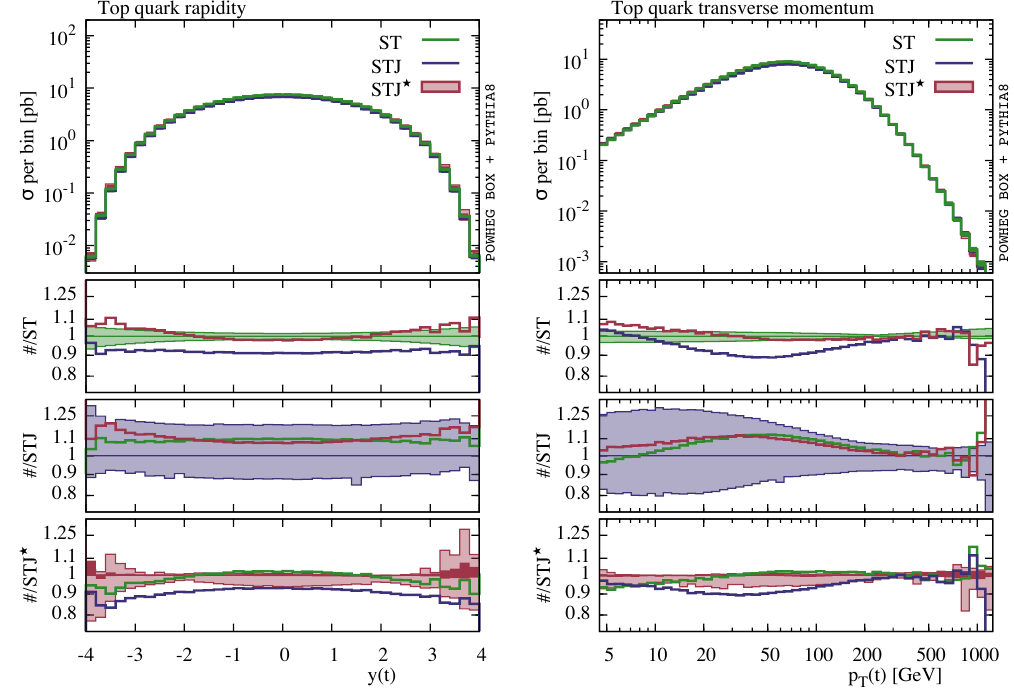
Figure 2 . Rapidity (left) and transverse momentum (right) of the top quark in t -channel single-top production. Predictions from the Powheg ST program [52] are shown in green. Results from the new Minlo STJ simulation are displayed in blue, while those of its improved counterpart, STJ ? , appear in red. All predictions include parton shower e(cid:11)ects simulated by Pythia8 [101]. provides NLO accurate predictions for these observables, while STJ (blue) is formally